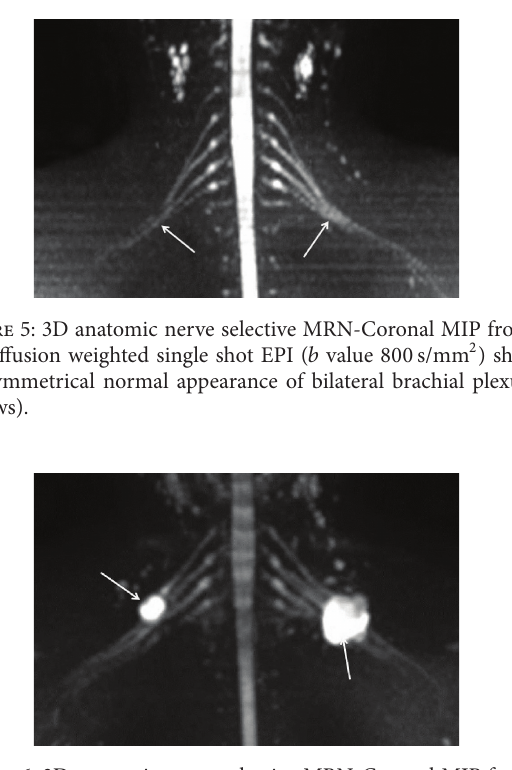
Figure 6: 3D anatomic nerve selective MRN-Coronal MIP from a 3DdiffusionweightedsingleshotEPI( 𝑏 value800 s/mm 2 )showsthe peripheral nerve sheath tumors originating from the right C5 nerve root and the left upper trunk